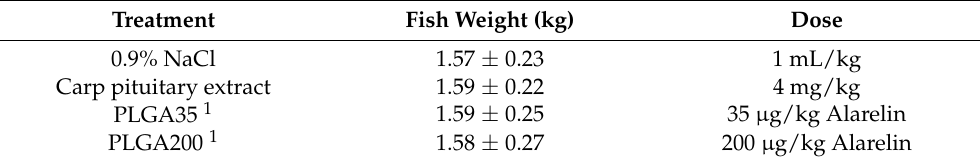
Table 1. Experimental groups of sterlet males . Treatment